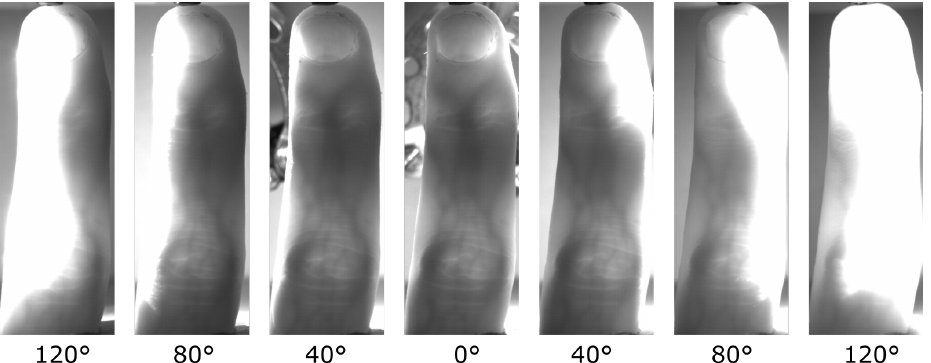
Figure 8. Multiple images of view to finger bloodstream with same intensity of light and different po-